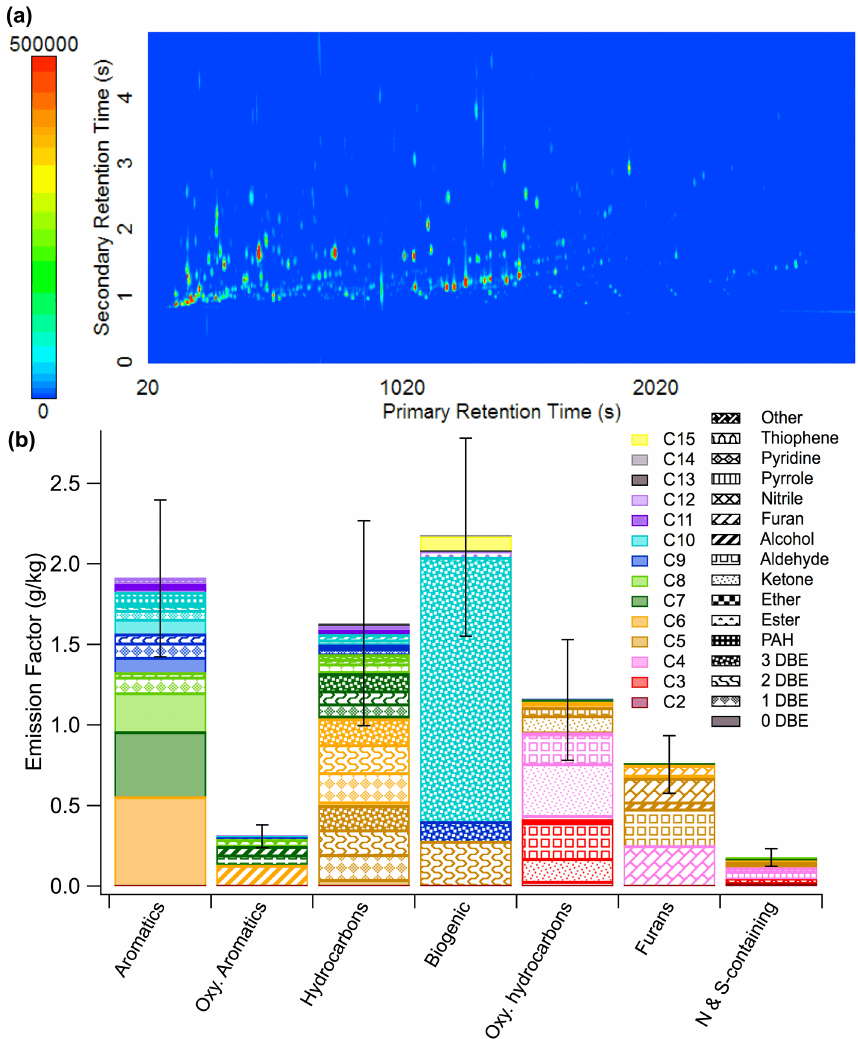
Figure 1. (a) GC × GC–ToFMS chromatogram of NMOC emissions from a black spruce (BS) fire. The color scale saturates at 500000area units. (b) Summary of the compounds observed by GC × GC–ToFMS during the BS fire. Colors indicate carbon number and patterns indicate functionality. (DBE are double bond equivalents, which for aromatic compounds refers to the substituents